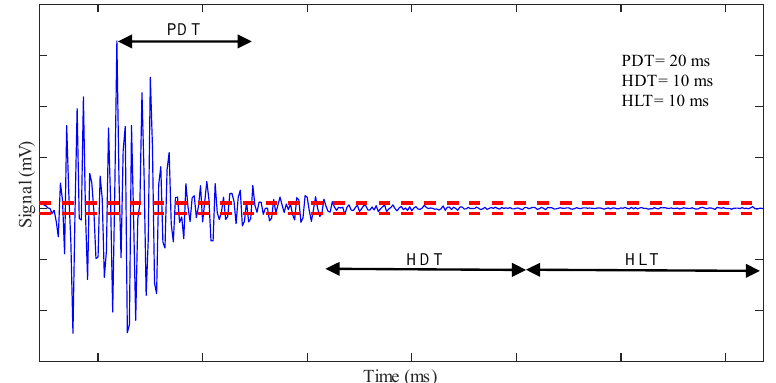
Figure4. Peakdefinitiontime(PDT),hitdefinitiontime(HDT),andhitlockouttime(HLT).Theydiscriminate Figure 4. Peak definition time (PDT), hit definition time (HDT), and hit lockout time (HLT). They one hit from discriminate one hit from another.